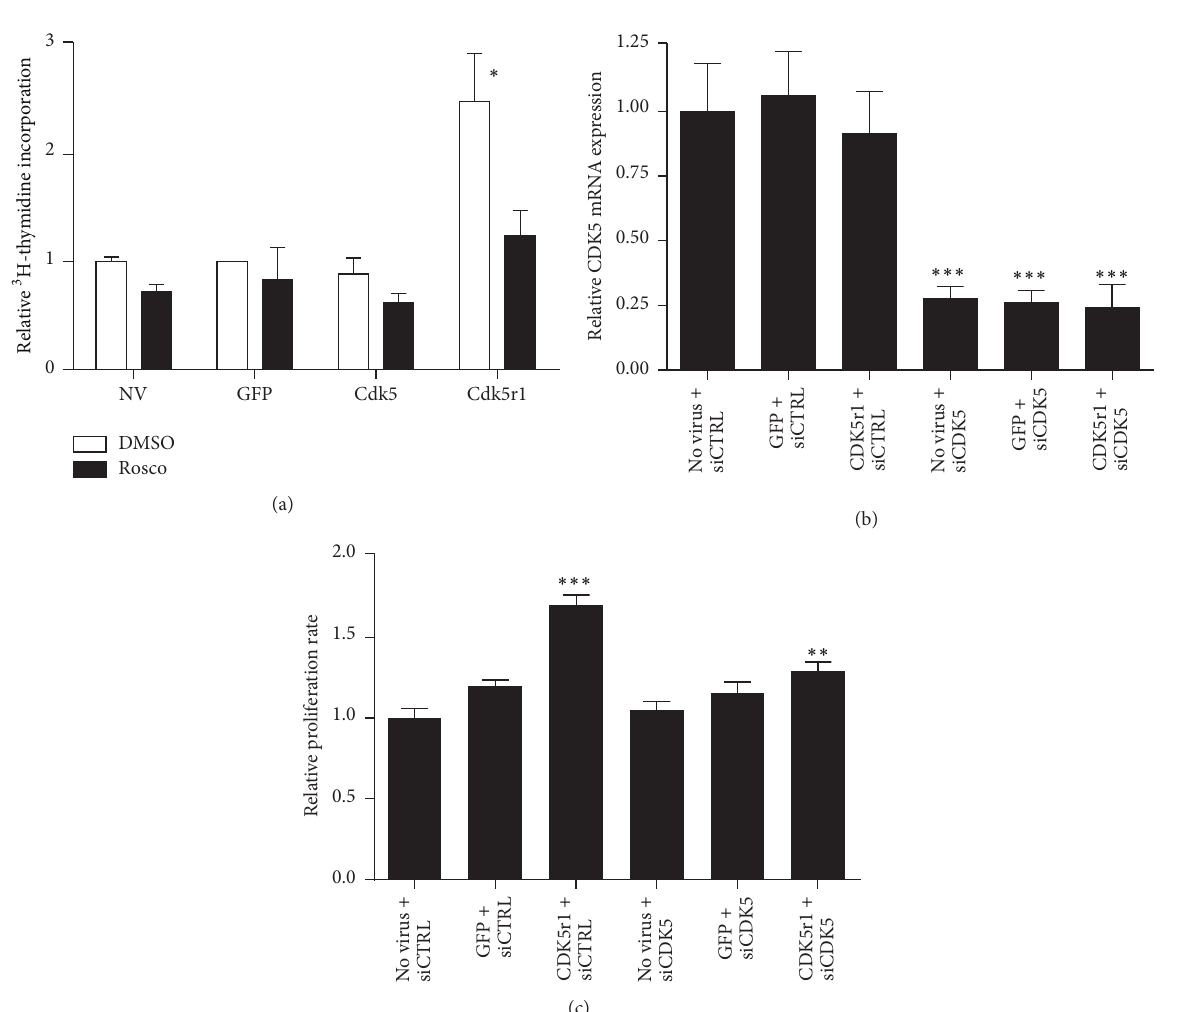
Figure 7: Cdk5r1 mediated 𝛽 -cell proliferation is dependent on the Cdk5 kinase activity. (a) Islets transduced with AdCMV-GFP, AdCMV- Cdk5, or AdCMV-Cdk5r1 were cultured in the presence of 3 H-thymidine for 48 hours. Islets were treated with vehicle or 10 𝜇 M roscovitine for the final 24 hours of the labeling period. Data represent the mean ± SEM of four independent experiments. (b) 832/13 cells were transfected with siCDK5 or siCTRL. Twenty-four hours later cells were transduced with AdCMV-GFP or AdCMV-Cdk5r1. Cdk5 mRNA was measured by RT-PCR, demonstrating a significant decrease in Cdk5 levels with siCDK5 transfection. (c) Proliferation was measured by cell counts, demonstrating that knockdown of Cdk5 causes a significant impairment of Cdk5r1 mediated proliferation. Data represent the mean ± SEM of three independent experiments. (c) ∗ 𝑝 ≤ 0.05 . p value represents the comparison between Cdk5r1- and GFP-treated